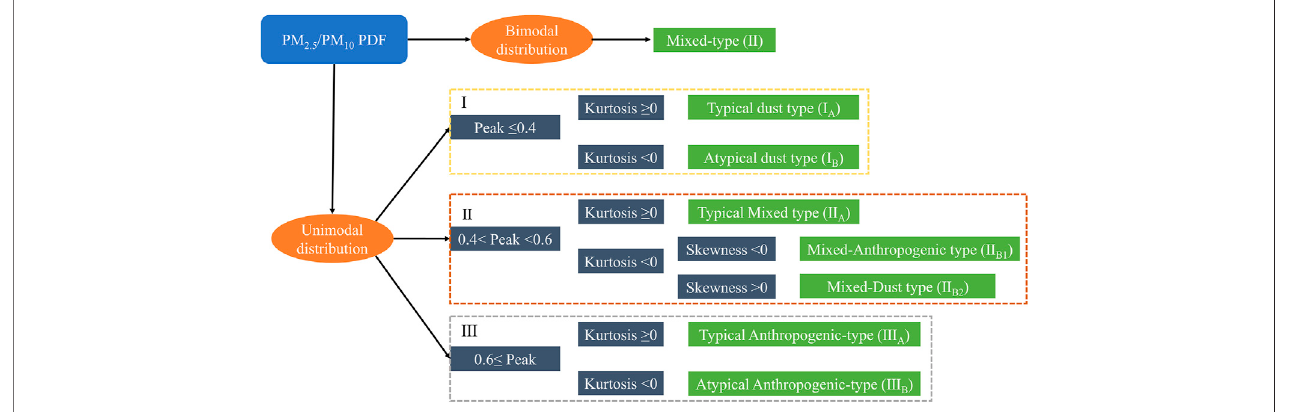
FIGURE 2 | Flow chart of urban pollution classi fi cation method proposed in this study based on the PM 2.5 /PM 10